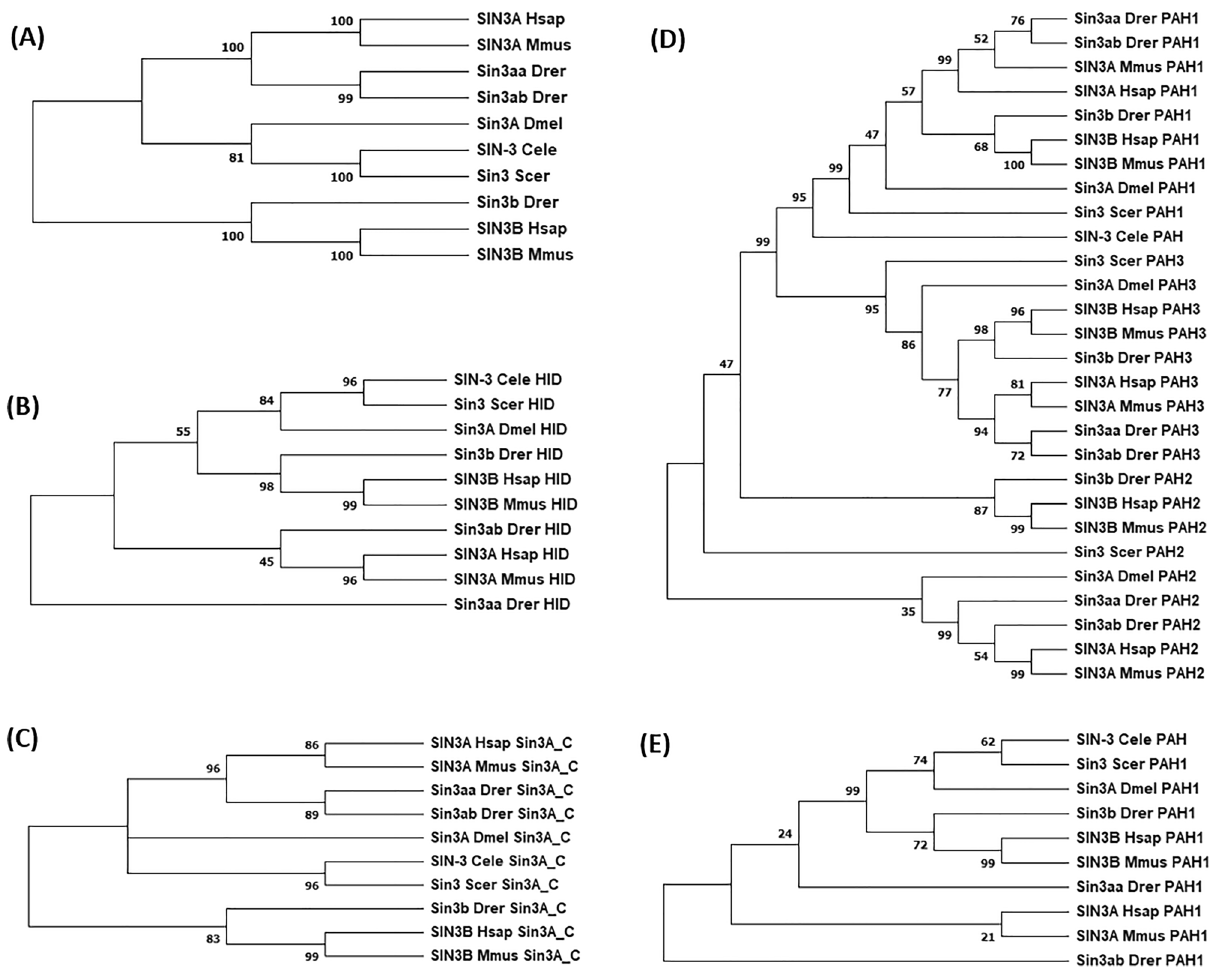
Figure 1. SIN3 phylogeny based on alignments of the amino-acid sequences of Caenorhabditis elegans SIN-3 protein and its domains. Phylogenetic tree based on ( A ) SIN3 protein, ( B ) SIN3 HID domain, ( C ) SIN3 SIN3A_C domain, ( D ) SIN3 PAH domain, and ( E ) SIN3 PAH1 domain. The PAH1 domain was analysed separately due to its high sequence identity with PAH domain of C. elegans SIN-3 protein. The Phylogenetic tree